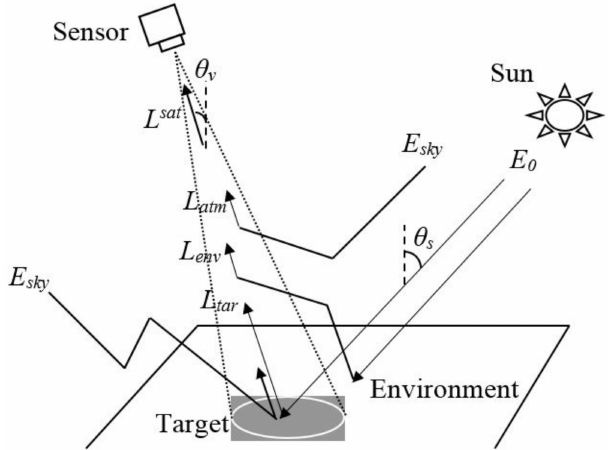
Figure 1. Solar radiation components received by a remote sensing sensor according to the Second Simulation of the Satellite Signal in the Solar Spectrum (6S)